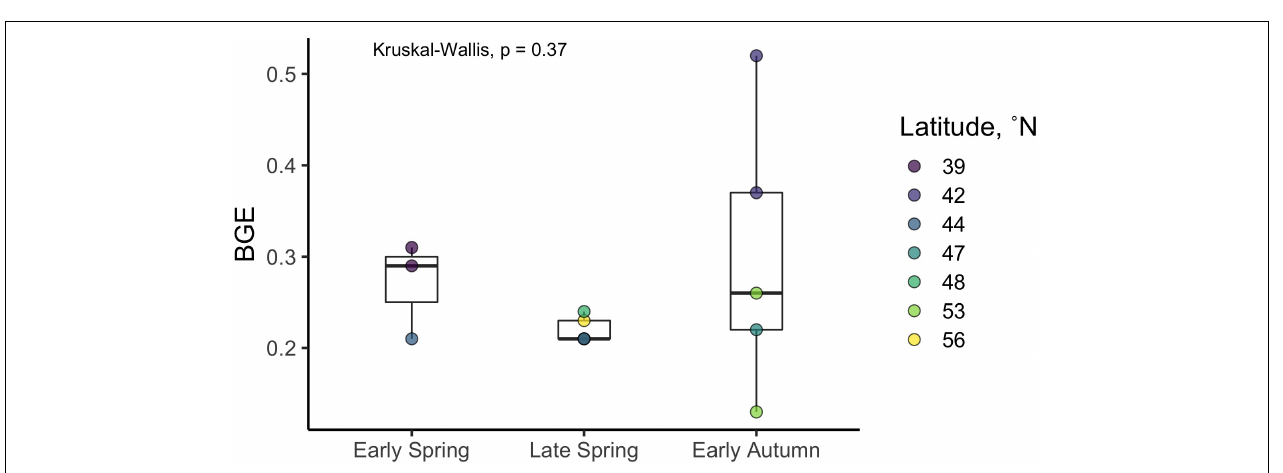
FIGURE 5 | Bacterioplankton growth efficiency (BGE) estimates derived from the DOC remineralization experiments. Filled circles represent individual incubations, and filled colors represent the station where the experiment was conducted (see Table 1 for corresponding station latitudes). Boxes represent the 1.5 interquartile range, with the internal solid line representing the median. p -values are reported for the nonparametric Kruskal–Wallis test (one-way ANOVA on ranks), which tests if the means of all groups are equal.